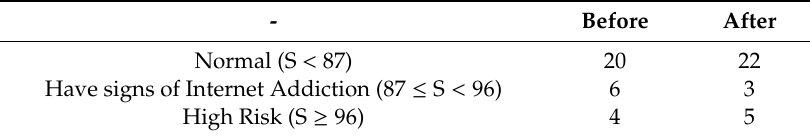
Table 8. Pre- and post-test on distribution of change in Internet